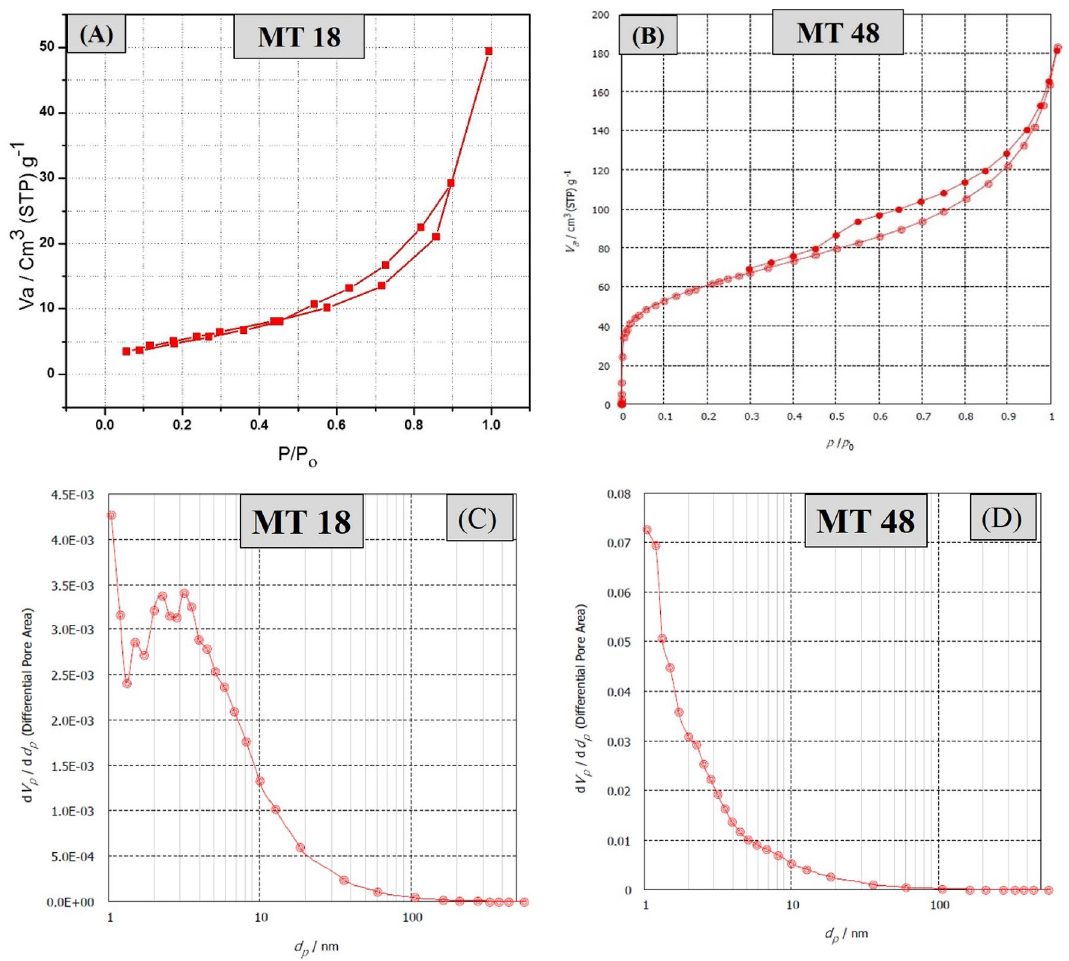
Figure 3. ( A , B ) Adsorption/desorption isotherm of both MT18, and MT48 samples, and ( C , D ) BJH-plot adsorption branch, adsorptive N2, adsorption temperature 77.350 K of both MT18, and MT48.